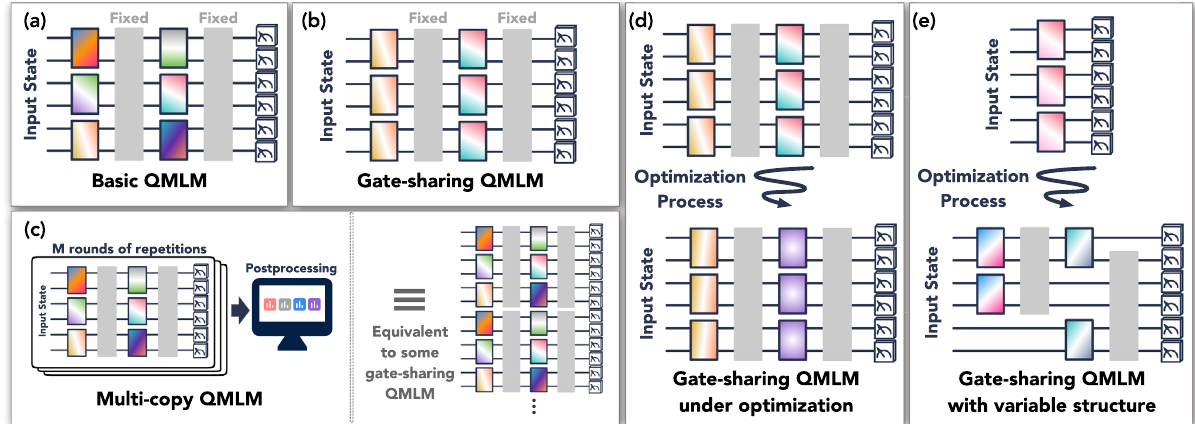
with T =6 parameterized gates, in which each gate is repeated M times. Panel ( d ) describesagate-sharingQMLMunderoptimization.Theparameterizedgatetothe leftundergoesasmallchange,whiletheonetotherightundergoesalargechange. If we sort the changes Δ 1 , Δ 2 from large to small, then Δ 1 ≫ Δ 2 ≈ 0. Finally, panel ( e ) illustrates gate-sharing QMLM with variable structure. The number T of para- meterized gates changesthroughout the optimization. The fi gurebegins with T =1 and ends with T